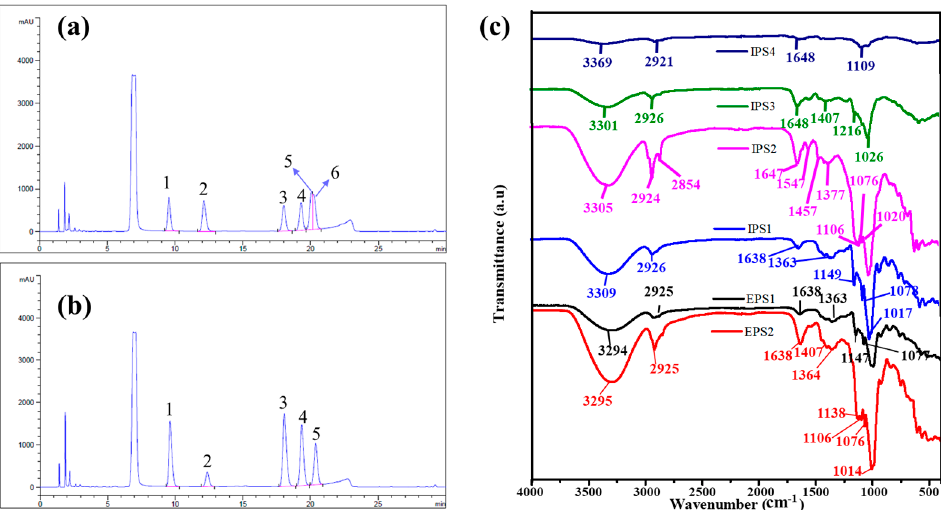
Figure 2. Determination of monosaccharides by HPLC using the UV detector: standard chromatogram of monosaccharide mix contains mannose (1), ribose (2), glucose (3), galactose (4), xylose (5), and arabinose (6) ( a ); determination of monosaccharides in EPS1 ( b ); and FTIR spectral analysis of EPSs and IPSs ( c ). The raw data of FTIR analysis are provided in the Supplementary Materials (SI. FTIR of EPSs and IPSs as zip file).